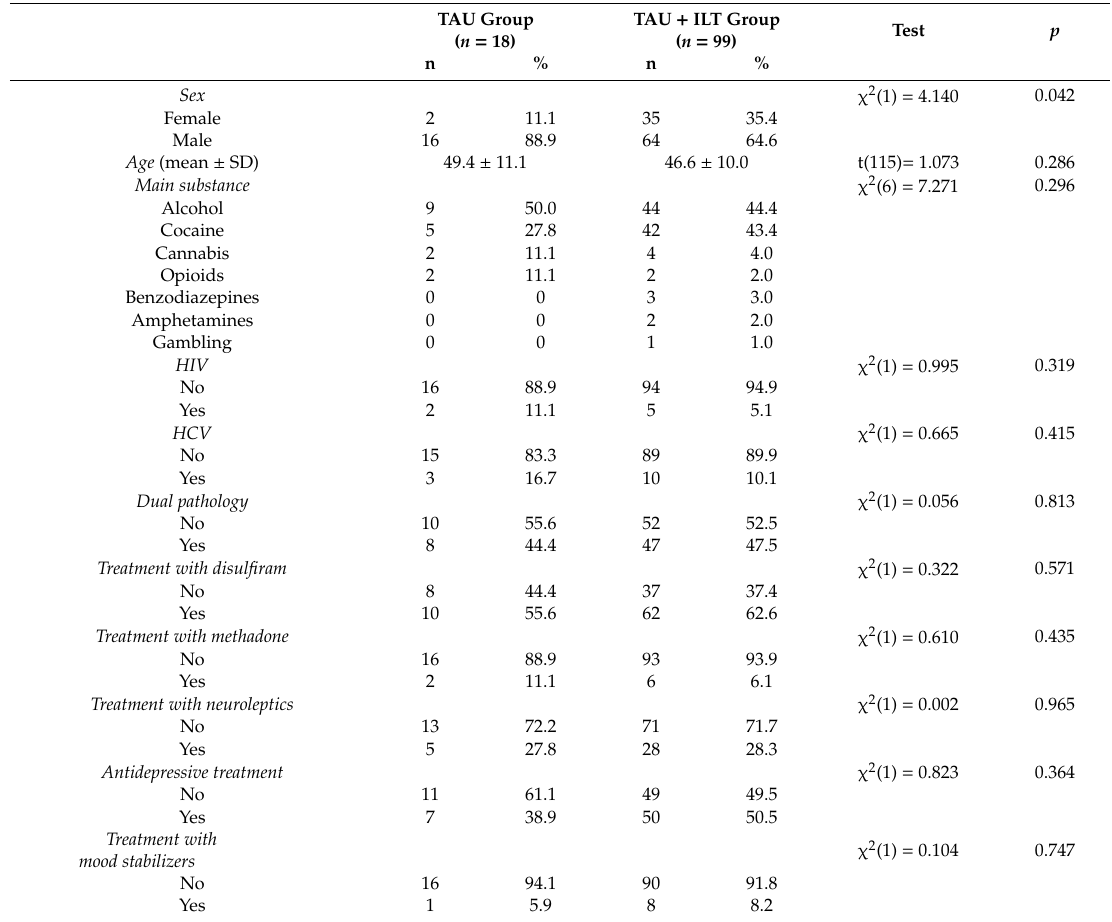
Table 2. Sociodemographic and clinical characteristics.